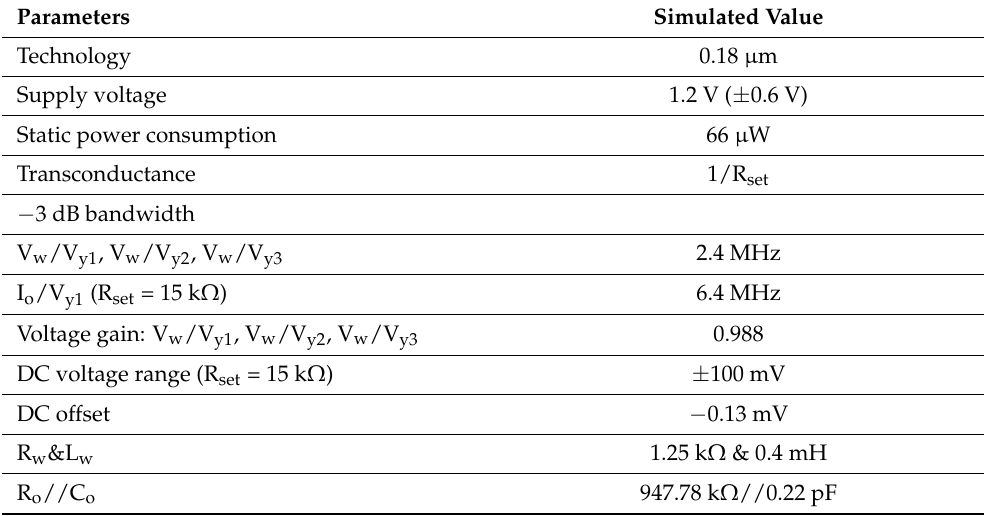
Table 2. Simulated parameters of used DDTA.